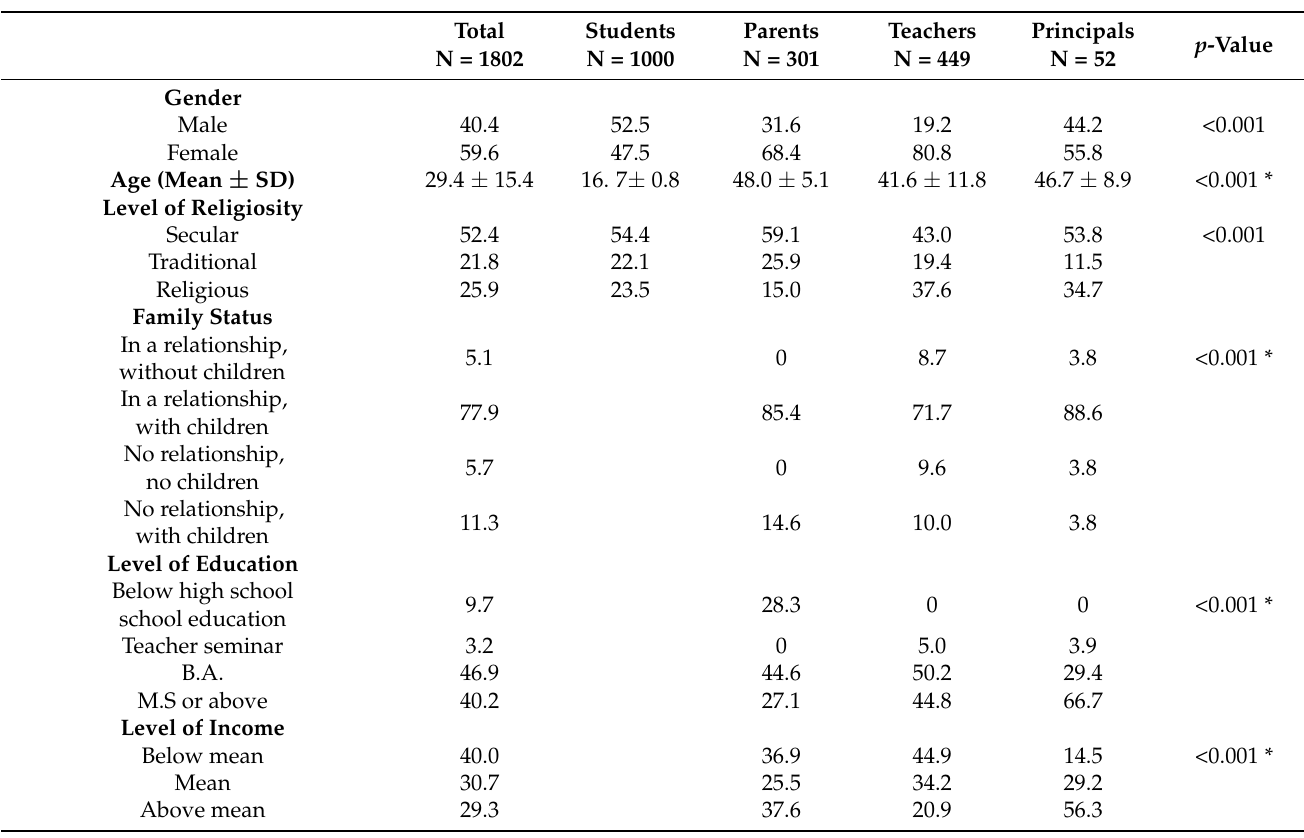
Table 1. Demographic characteristics according to the four stakeholder groups (Students, Parents, Teachers, and